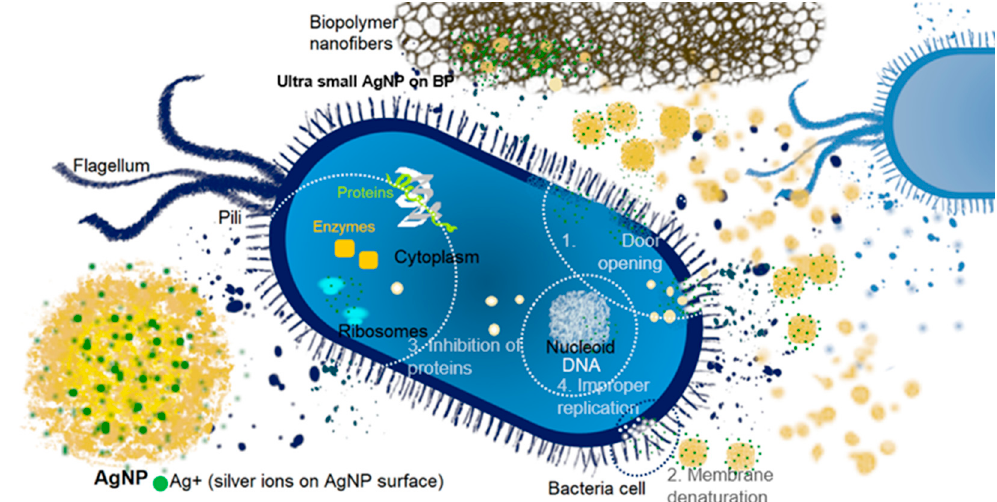
Figure 15. Scheme of the antibacterial actions of silver nanoparticles (AgNP) and silver ions (Ag+) against the bacteria model, illustrating the behavior of the systems considered in this work (AgNP in BP/AgNP (as big yellow AgNP) and BP/AgP (as small AgNP on biopolymer nanofibers).